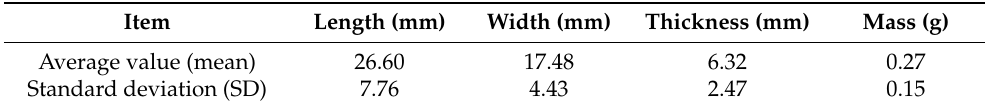
Table 1. Basic parameters of sugarcane bagasse used to evaluate its feasibility as a carbon source in aerobic denitrification of